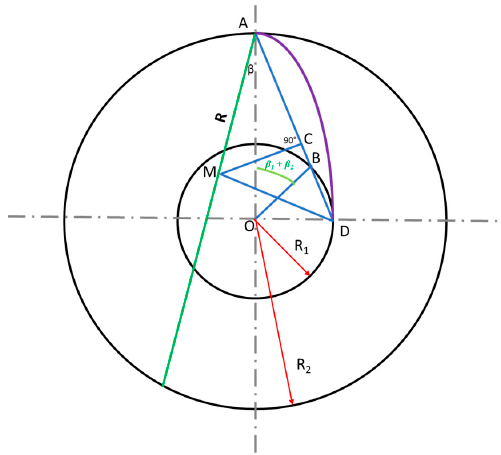
Figure 17. Simple geometric method of constructing vane profile.